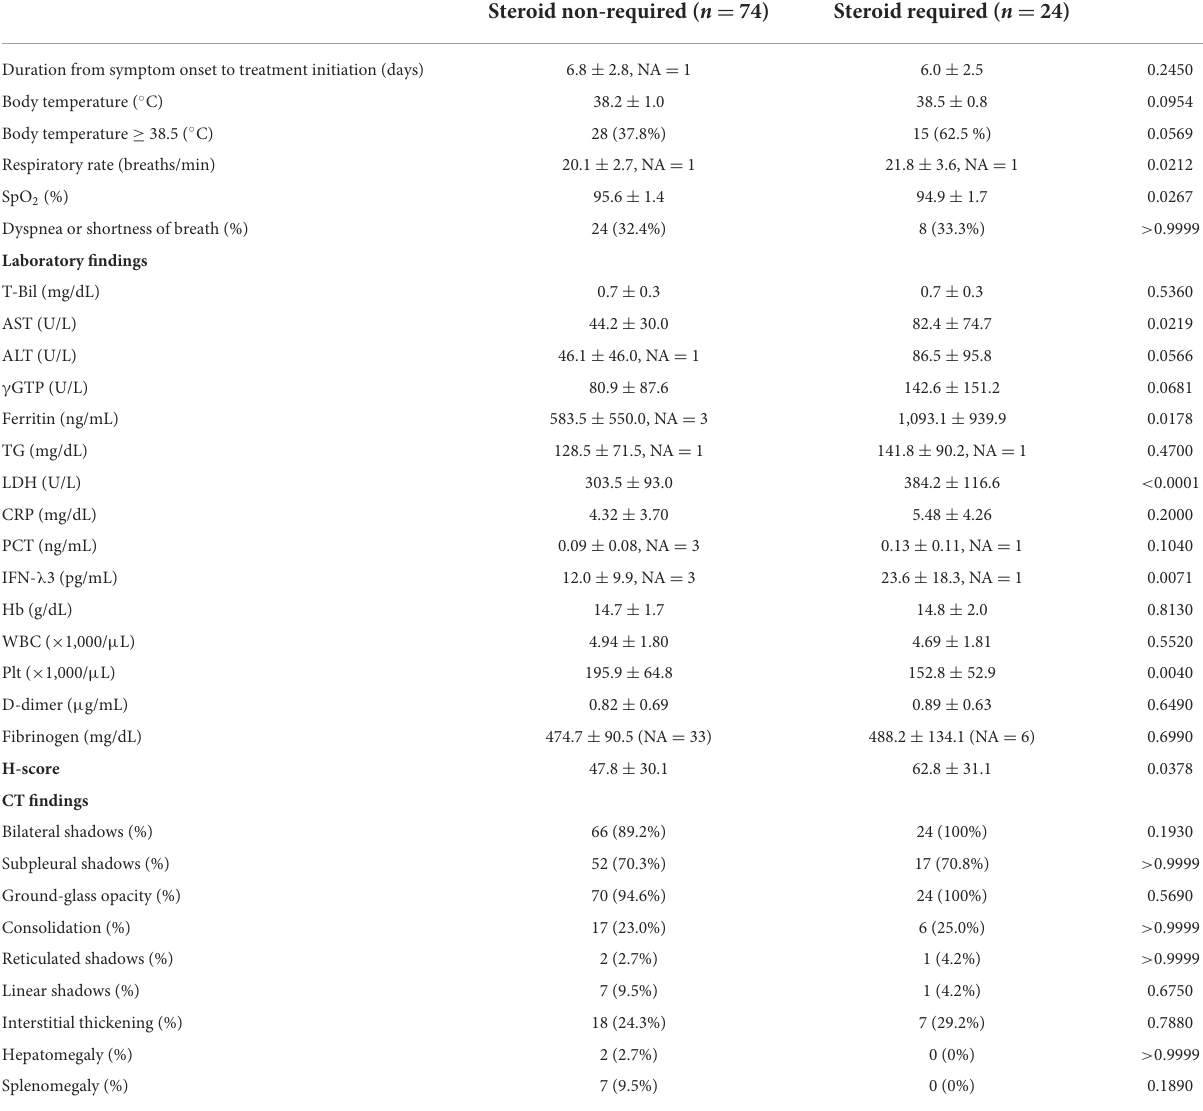
TABLE 2 Characteristics and outcomes of patients on admission.